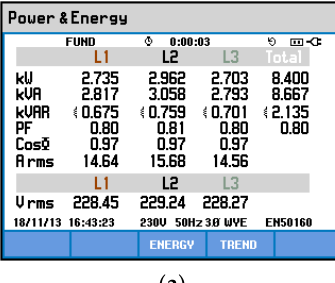
Figure 28. Case 1 - system without filters: ( a ) source power; ( b ) voltage and current waveforms in phase S .